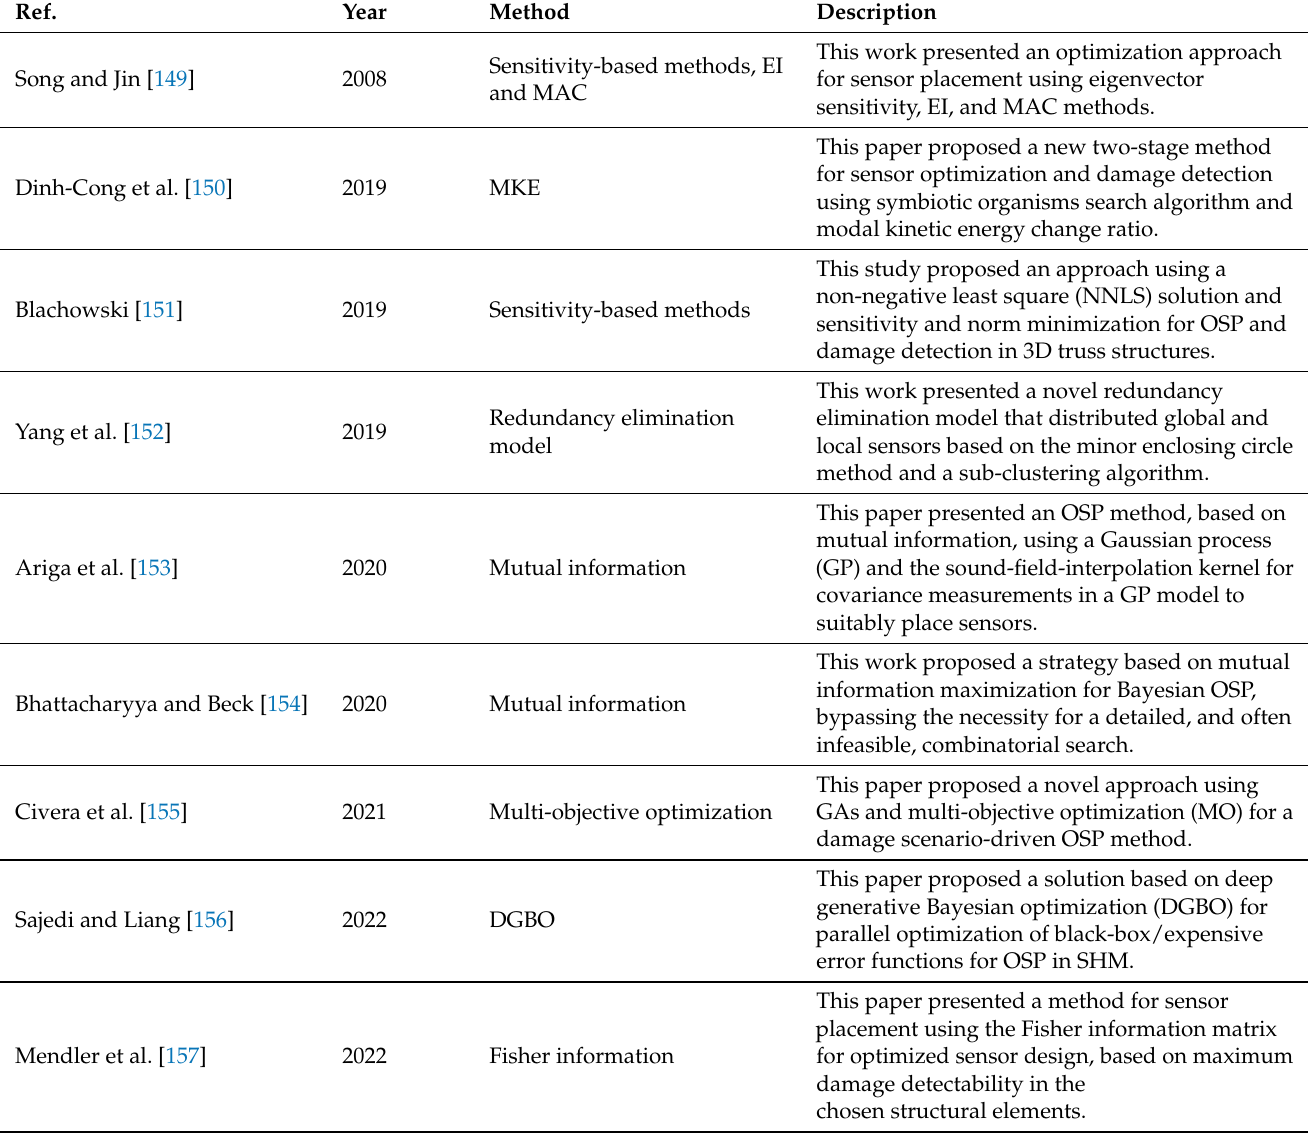
Table 11. Recent papers on OSP